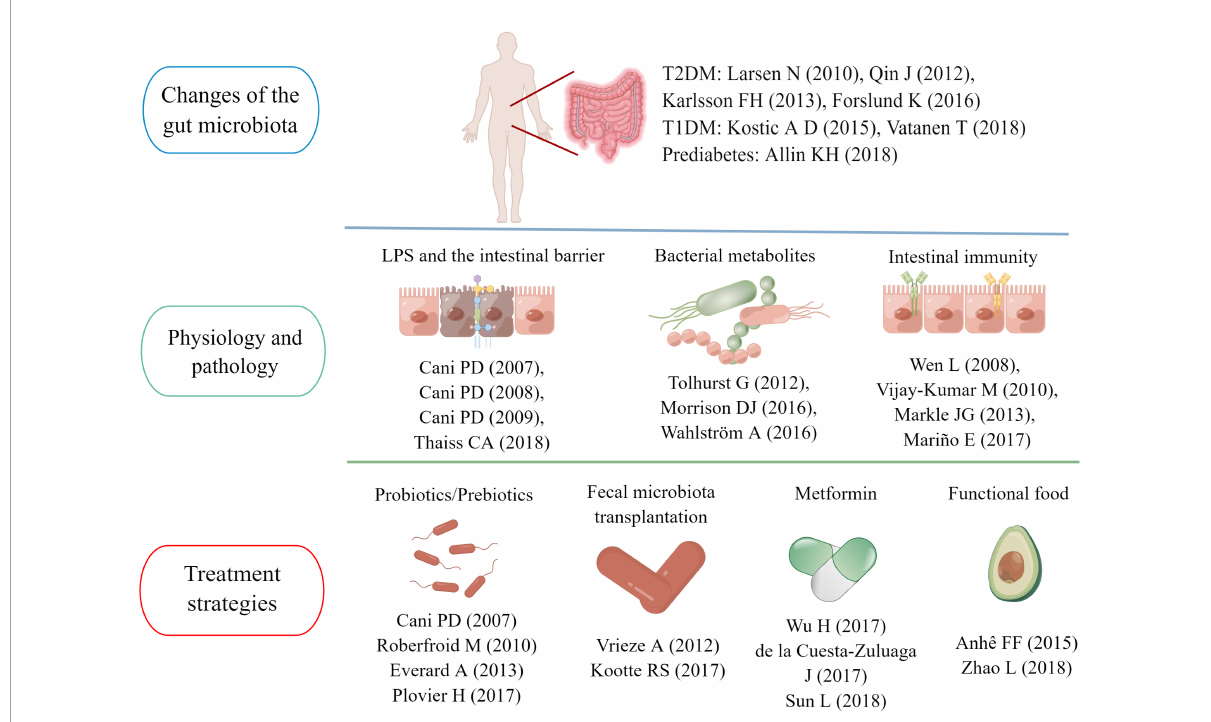
FIGURE7 Main research topics of representative articles in the “gut microbiota and diabetes” area.